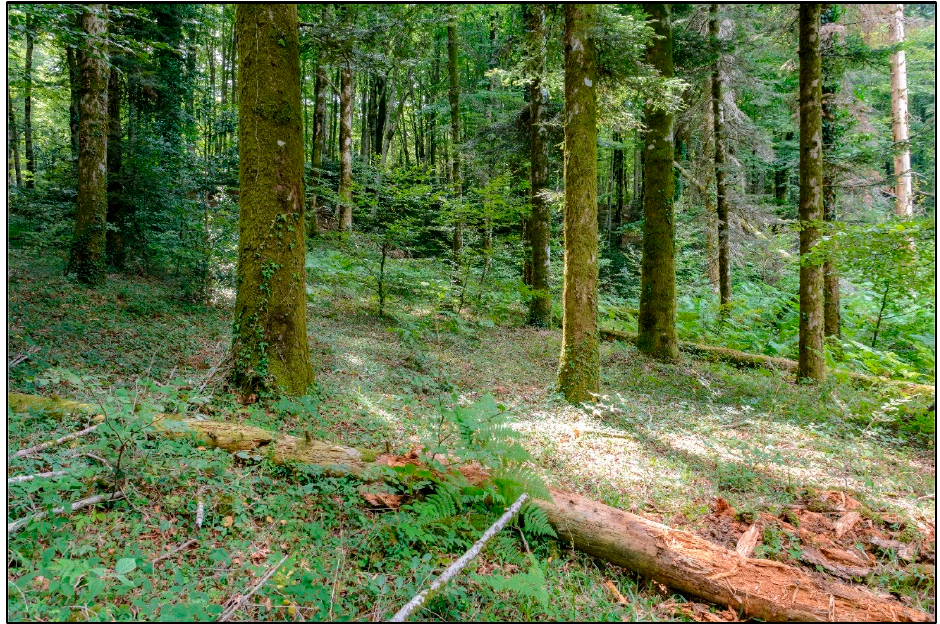
Figure 2. Forest habitat within the Riserva Naturale Biogenetica Marchesale where adults of Pycnomerus italicus (Ganglbauer, 1899) (Coleoptera: Zopheridae) were found.